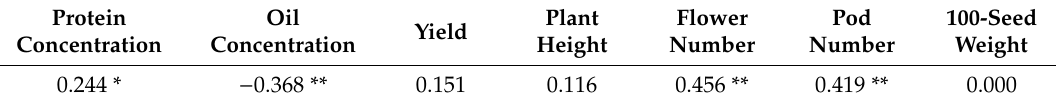
Table 10. Correlation coe ffi cient of yield and yield components traits with irrigation treatments. Protein Oil Concentration